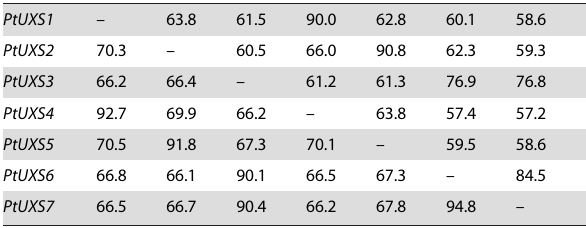
Nucleotide Diversity of PtUXS1 in Natural Populations To characterize the intraspecific molecular evolution of the poplar UXS genes, we first obtained genomic sequence of PtUXS1 from 44 unrelated individuals in a discovery population that represents almost the entire natural range of P . tomentosa . An approximately 4374 bp genomic region of PtUXS1 , including 133 bp of 5 9 UTR, 1293 bp of coding regions, 2574 bp of intron, and 374 bp of 3 9 UTR, was amplified and sequenced. Table 3